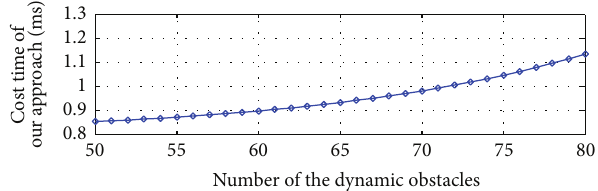
Figure 11: Cost time of our approach according to the number of the normal members in the